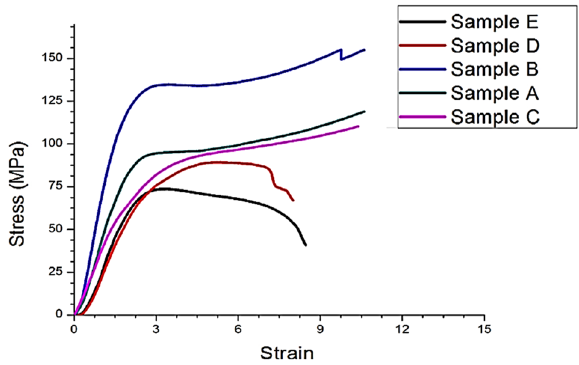
Fig. 2 TGA curves illustrating the thermal degradation temperatures of the PMMA based arti fi cial teeth